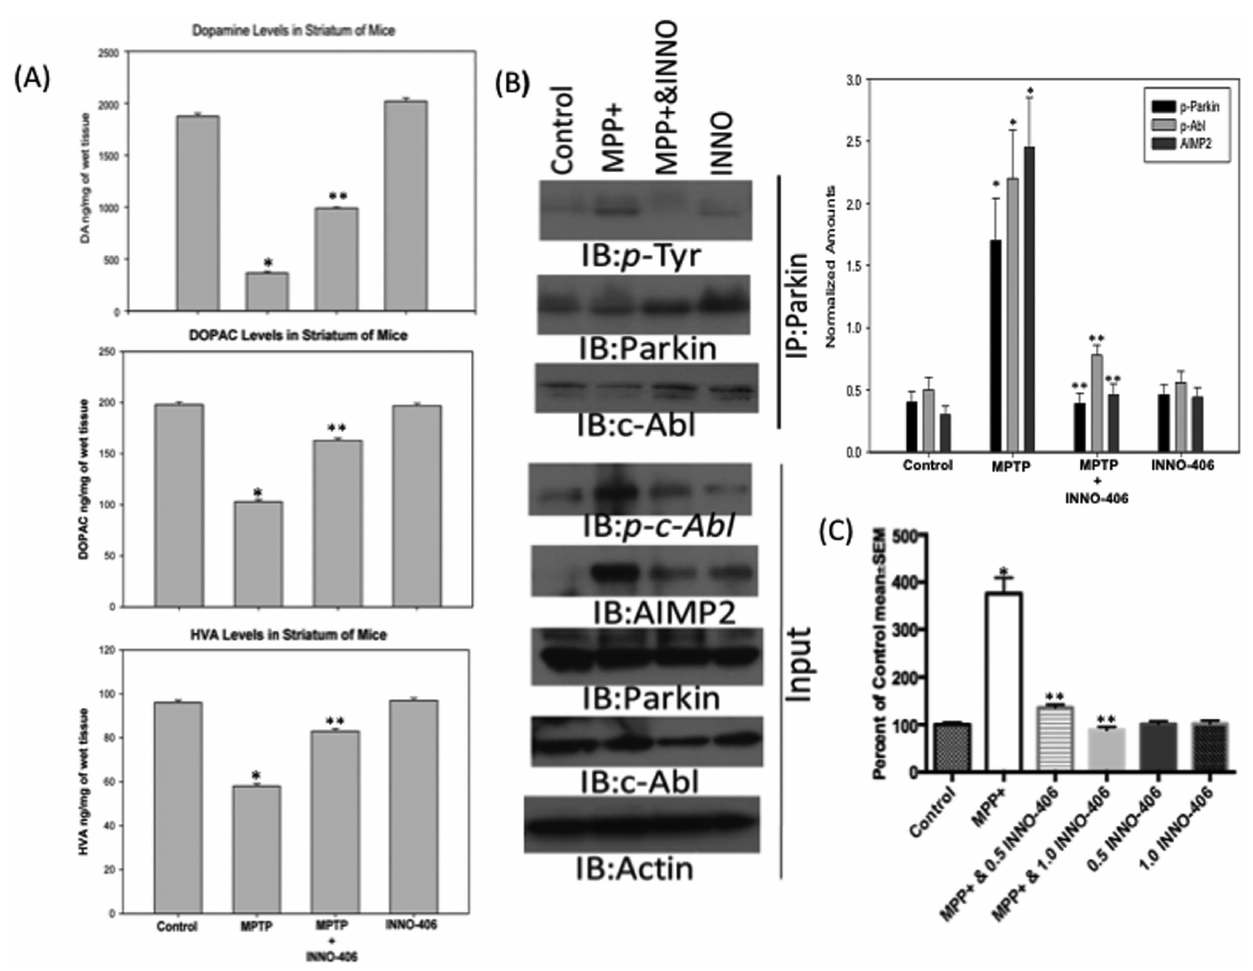
Figure 4. INNO-406 prevents dopaminergic depletion and c-Abl mediated parkin phosphorylation in mice striatum. (A) INNO-406 prevents MPTP-induced depletion of striatal dopamine and its metabolites DOPAC and HVA in adult male C57BL/J6 mice. Animals received INNO-406 (10 mg/kg, i.p.) as a single daily injection for 7 days before MPTP injection. On day 7 mice were treated with 4 6 20 mg/kg, i.p. of MPTP at 2 h interval. INNO-406 injection was continued for one more week after the last injection of MPTP. * Considered statistically significant from control (p , 0.05). ** Considered statistically significant from MPTP (p , 0.05). (B) Parkin is tyrosine phosphorylated in the striatal lysates of MPTP-treated mice. Animals received INNO-406 (10 mg/kg, i.p.) as a single daily injection for 7 days before MPTP injection. On day 7 mice were treated with 4 6 20 mg/kg, i.p. of MPTP at 2 h interval. INNO-406 injection was continued for one more week after the last injection of MPTP. Samples were immunoprecipitated with anti-parkin antibody and were immunoblotted for anti- p -tyrosine, anti-parkin or anti-c-Abl. A 10% input samples were immunoblotted for anti- p -c- Abl, anti-parkin, anti-AIMP2, anti-c-Abl and ant-Actin. A pretreatment with INNO-406, a c-Abl kinase inhibitor, blocks oxidative stress-mediated tyrosine phosphorykation of parkin, activation of c-Abl and accumulation of toxic substrate, AIMP2, in the striatum of MPTP-treated mice. The photomicrograph shown is a representative of three repeats from samples pooled from 3 different animals. The optical density quantification data as normalized amounts is presented. * Considered statistically significant from control (p , 0.05). ** Considered statistically significant from MPTP (p , 0.05). (C) Cytotoxicity plotted as a percentage of control as measured by LDH in SH-SY5Y cells treated with MPP + (500 m M). Some samples were incubated with 0.5 or 1.0 m M INNO-406 for 6 h before MPP + treatment. *p , 0.05. Differences among means were analyzed using one-way analysis of variance (ANOVA). All experiments were repeated at least three times and representative examples are presented.